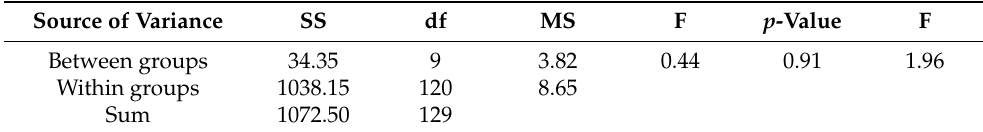
Table 6. Analysis of